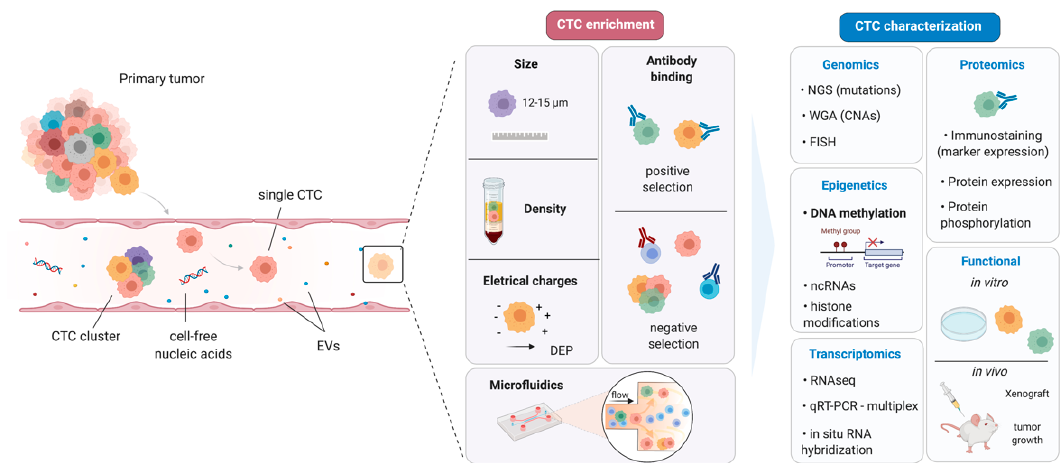
Figure 1. CTC enrichment methods and characterization. CTCs can be enriched on the basis of their physical or biological properties, such as size, density, electrical charge, antibodies, and/or the use of microfluidic devices. After enrichment, several methods can be applied to characterize the various subgroups of CTCs, using well-known technologies, including methylation analysis of target genes. CTC: Circulating Tumor Cell; EVs: Extracellular Vesicles.